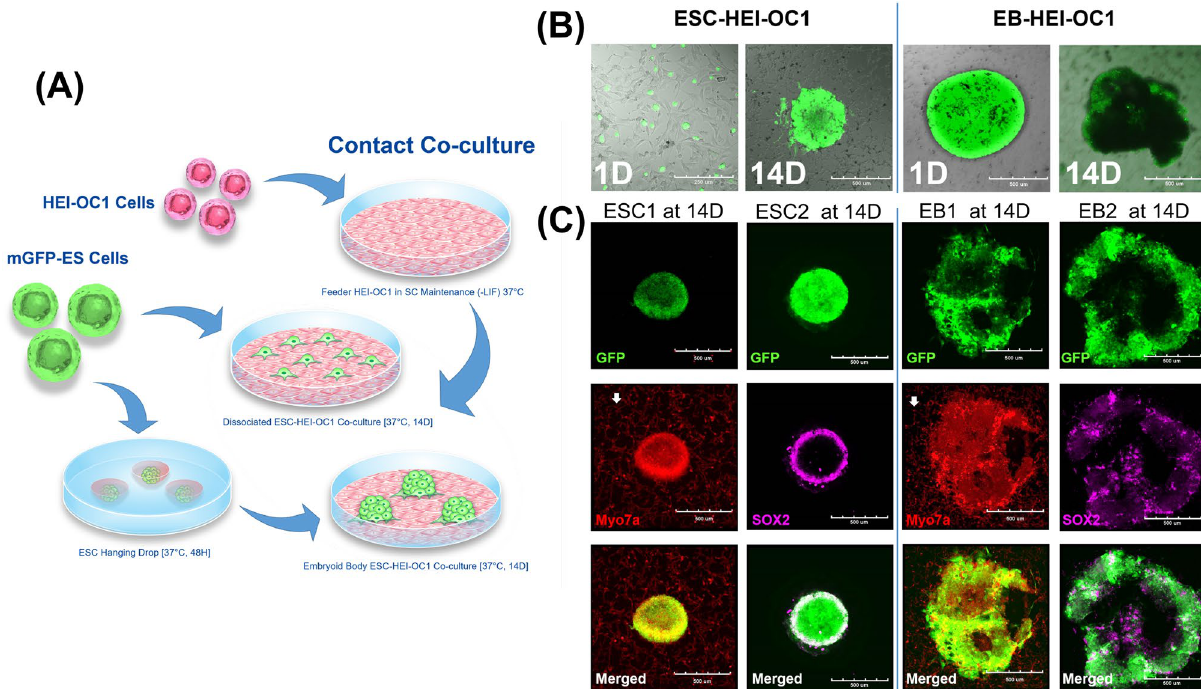
Figure 2. Contact co-culture of dissociated embryonic stem cells (ESC)s and embryoid bodies (EB)s with HEI-OC1 cells induced differentiation into otic cells. ( A ) Methodology of contact co-culture is shown. HEI-OC1 cells were preconditioned as described in the “Materials and methods” and co-cultured with both dissociated ESCs and EBs generated by hanging drop for 14 days. ( B ) Representative image of two different co-cultures. Dissociated ESCs merged and formed aggregates at 14 days. Protruding structures at the periphery of EBs were observed after 14 days. ( C ) Epifluorescence analysis showing expression of otic marker Myo7a and neural marker SOX2. Myo7a and SOX2 were both expressed in aggregates formed by dissociated ESC culture and EBs. Overlap expression of GFP (from ESCs), Myo7a, and SOX2 were observed in both groups. Co-cultured HEI-OC1 cells were only stained by Myo7a (white